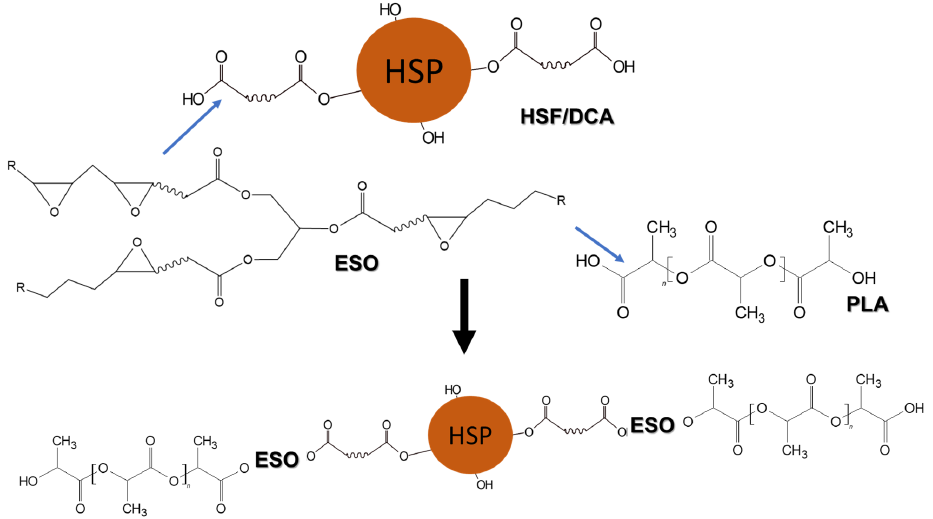
Figure 4. Scheme of the reaction occurring between HSP, ESO/DCA, and biopolyester matrix. According to this scheme, a stable bond between HSP and biopolyesters was formed after the reaction. For this reason, the investigation of composite with infrared spectroscopy after dissolution in chloroform of the matrix can give information about this reaction. In fact, the presence of bonded PLA (or PBSA) resulted in additional signals in the spectrum of F12 and F15